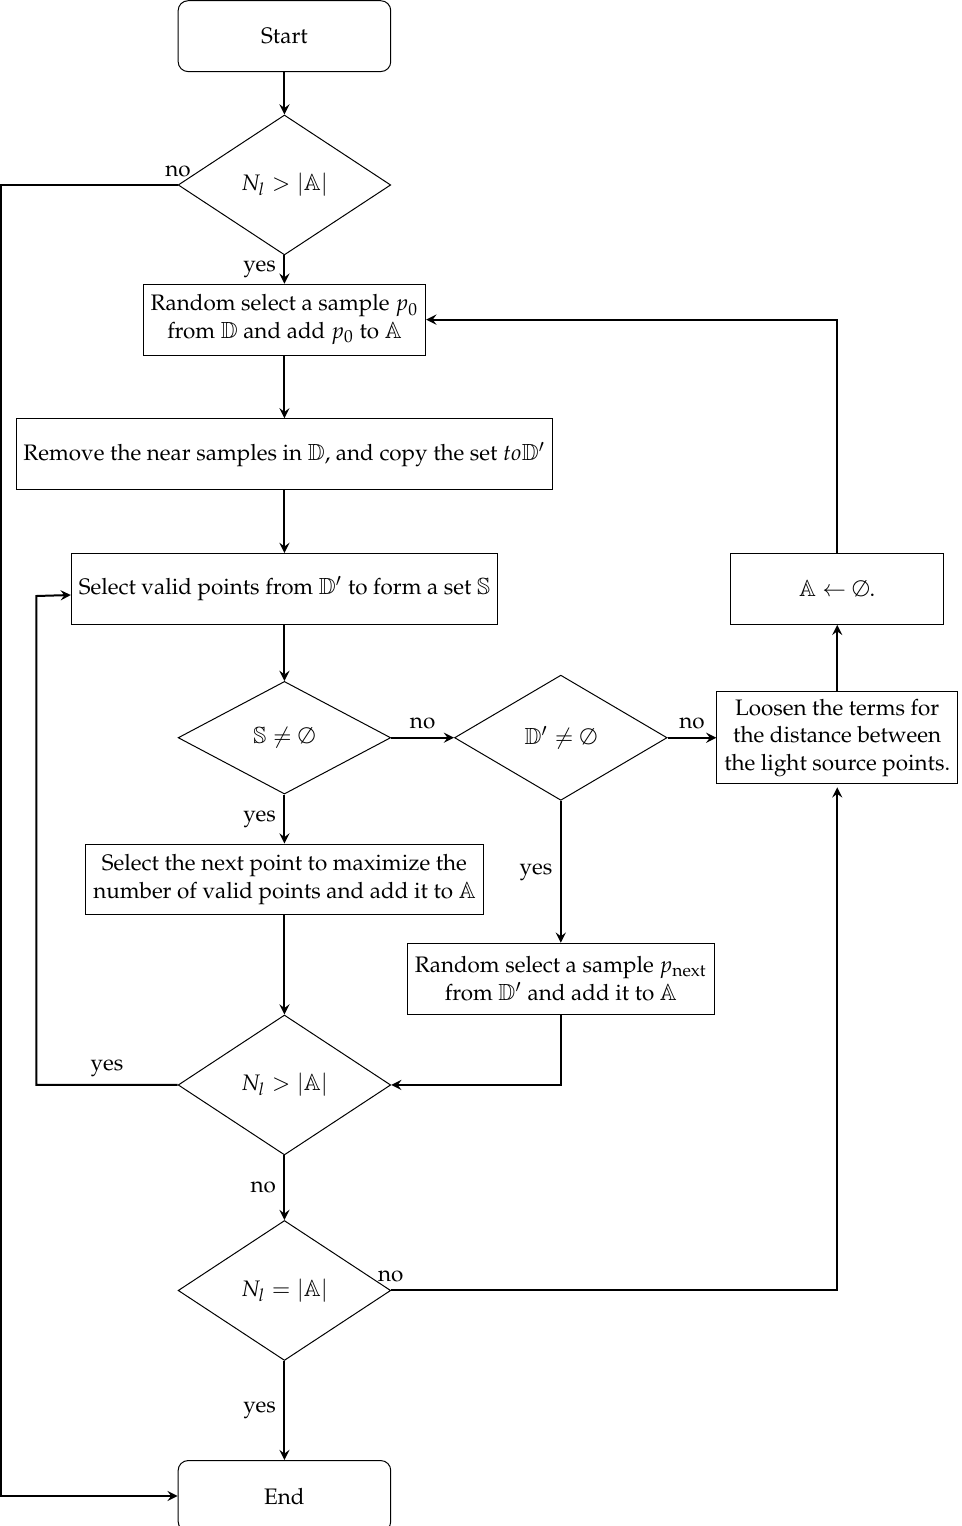
Figure 6. Flowchart of sampling light source from dithering